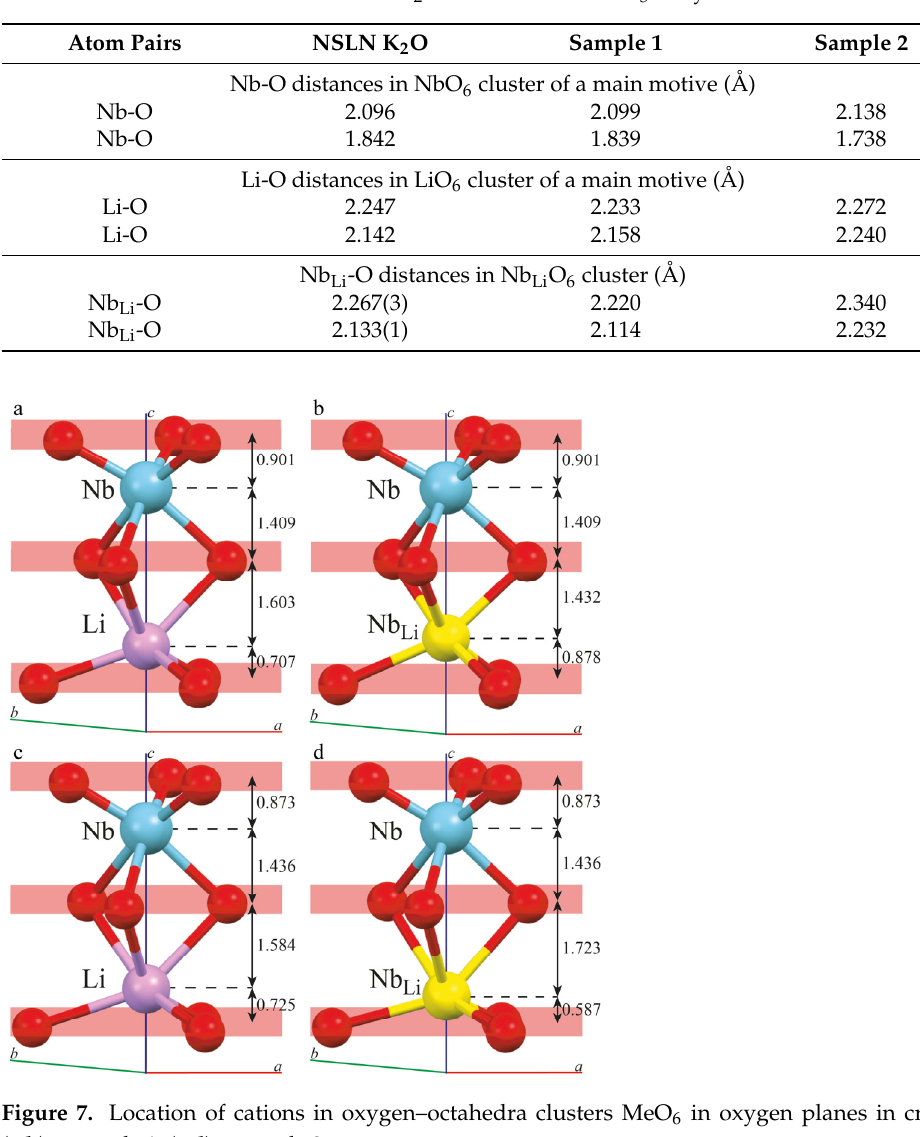
Table 5. Interatomic distances in NSLN K 2 O and studied LiNbO 3 :B crystals.